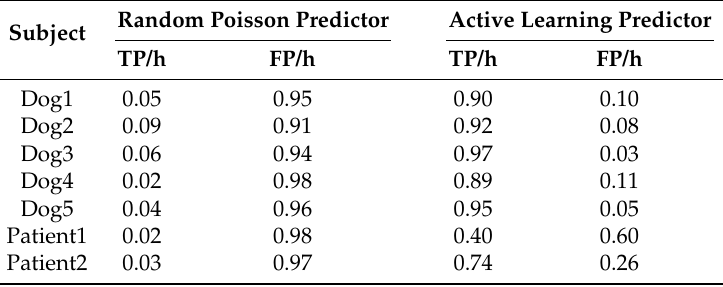
Table 17. Performance of active learning based seizure prediction framework in terms of True Prediction per hour (TP/h) and False Prediction per hour (FP/h) for the overall dataset using set t feature set.